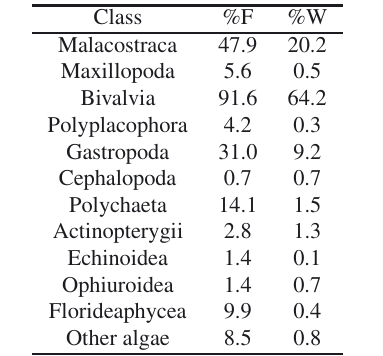
Table 4. Percentage of frequency of occurrence (%F) and percentage of weight proportion (%W) for each class of prey.